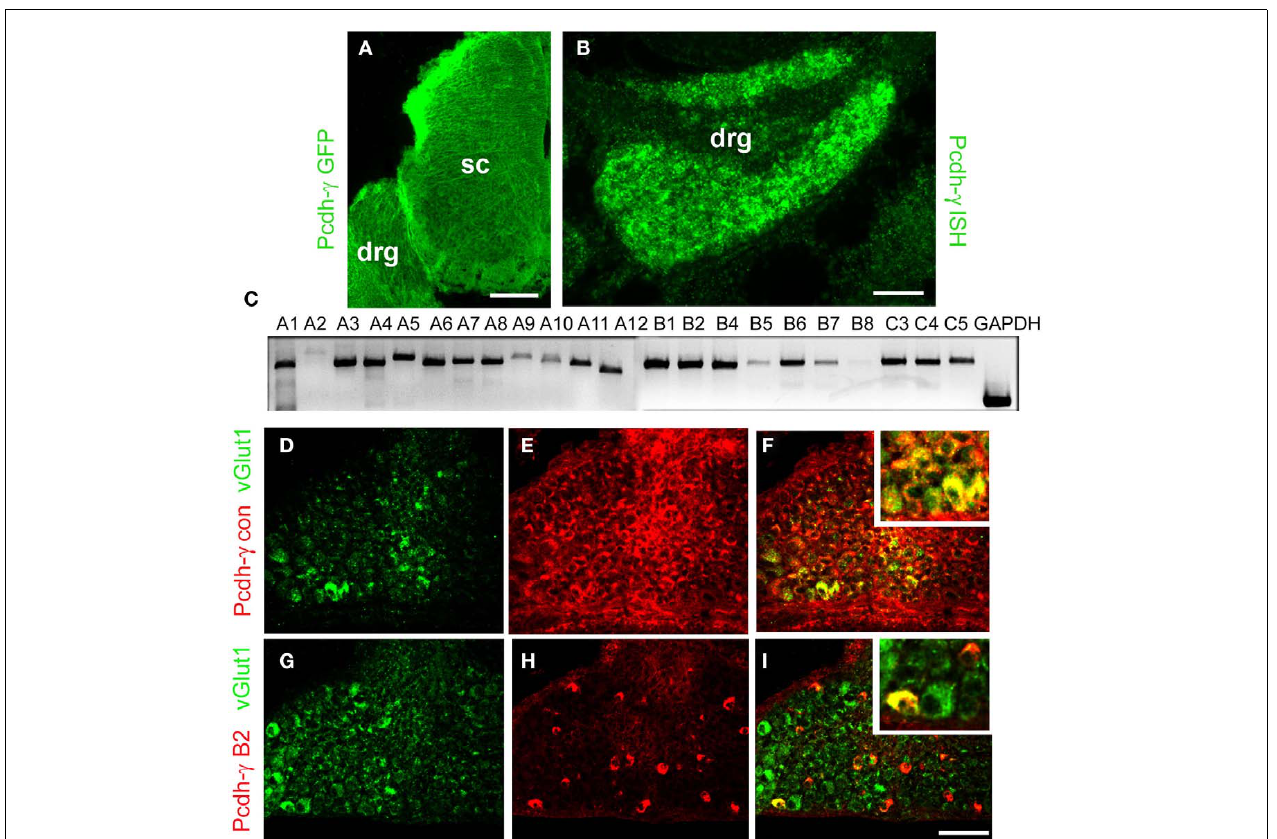
transcripts are expressed. (D–F) Immunostaining of P0 control DRG’s with antibodies against the γ -Pcdh constant region (red) and the Ia afferent neuron markerVGLUT1 (green) shows that all Ia neurons express some γ -Pcdh isoforms. (G–I) Immunostaining with antibodies specific for a single γ -Pcdh isoform (B2, red) andVGLUT1 (green) demonstrates that only a subset of sensory neurons, including a small number of Ia afferent neurons, expresses a given γ -Pcdh isoform. Insets, higher magnification view of a region in the main panel. Scale bar: 100 μ m in (A) , 50 μ m in (B) and (D–I)